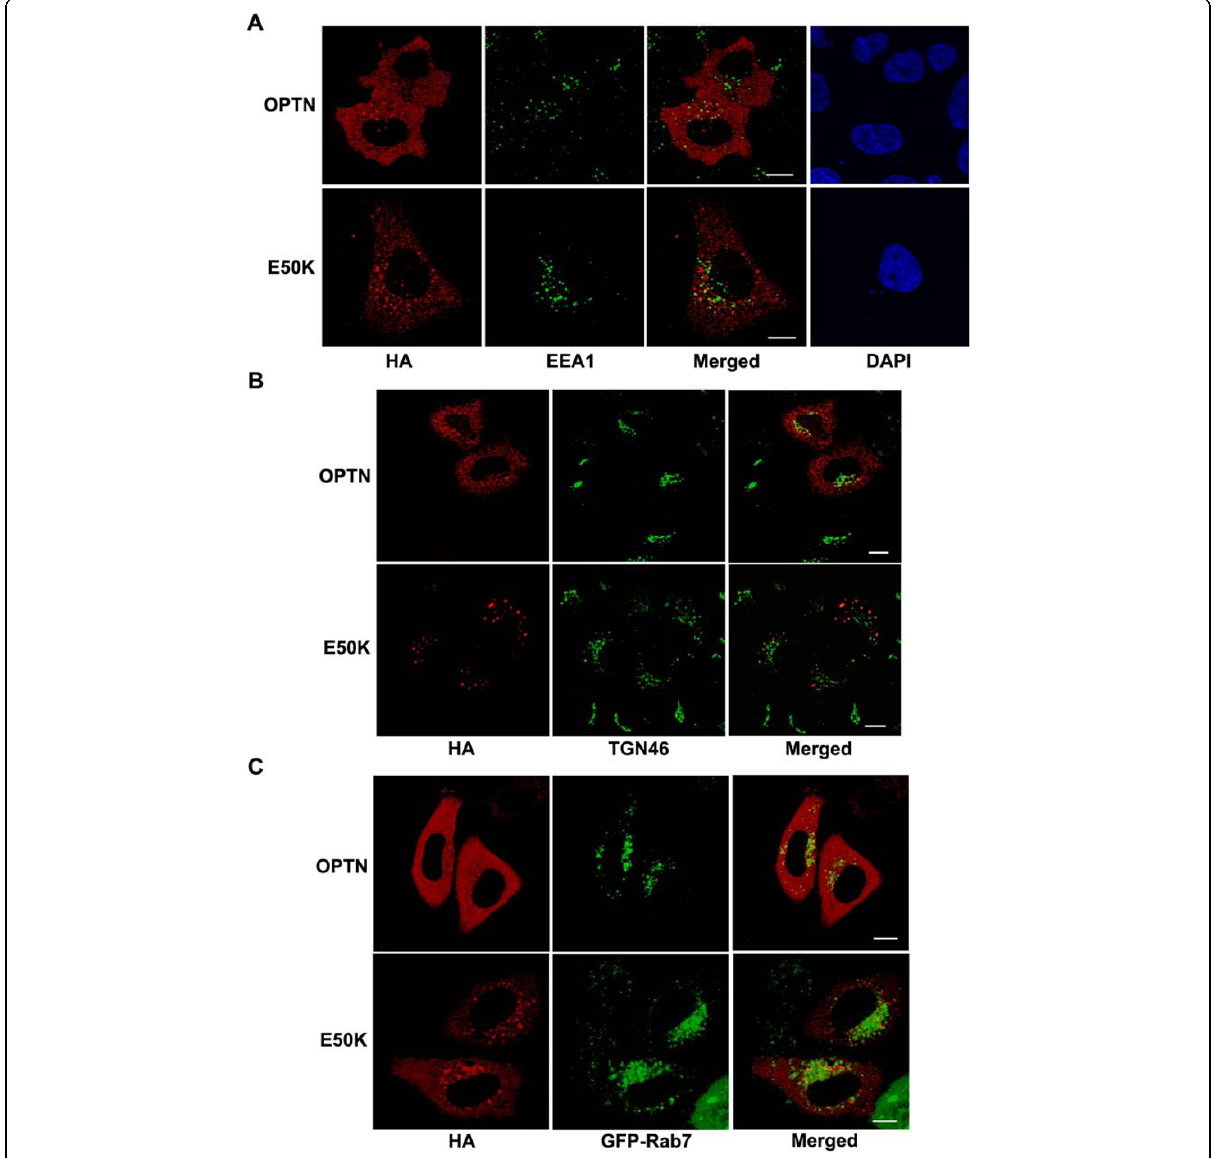
Figure 4 Characterization of subcellular localization of optineurin and E50K mutant . HeLa cells were transfected with HA-tagged wild type or E50K mutant optineurin and stained for (A) an early endosome marker EEA1 or (B) TGN46, a marker for trans-Golgi or (C) co-transfected with GFP-Rab7, a marker for late